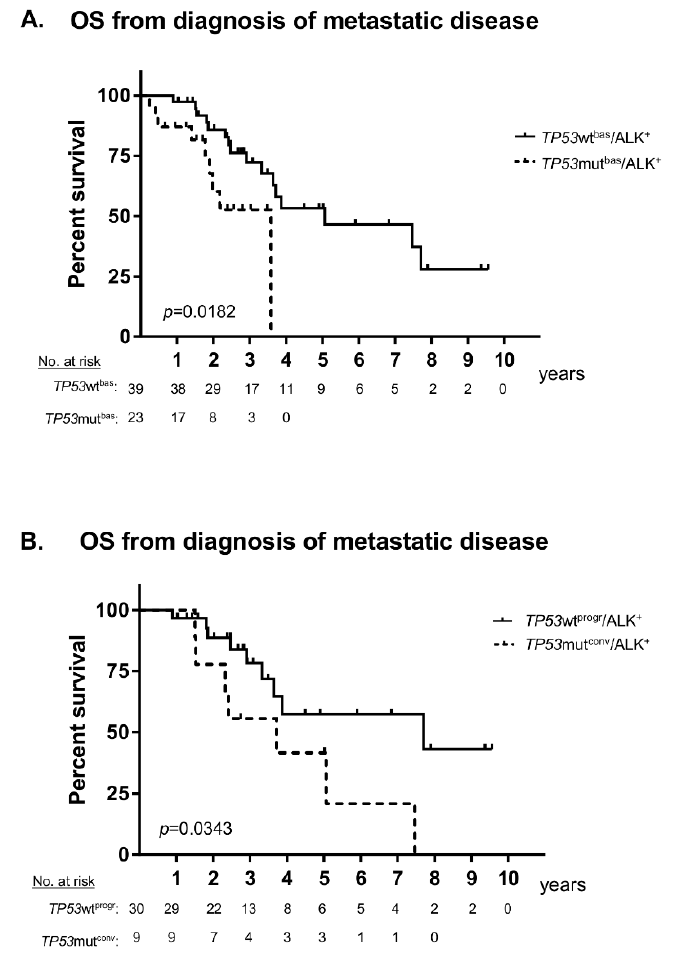
Figure 1. Overall survival of patients with metastatic anaplastic lymphoma kinase-positive (ALK + ) non-small cell lung cancer (NSCLC) according to TP53 status at baseline and progression. ( A ) The median overall survival (OS) was 44 months for patients with TP53 mutations at baseline ( TP53 mutbas) vs. 62 months for patients without TP53 mutations at baseline ( TP53 wtbas logrank p = 0.0182). ( B ) The median OS was 45 months for patients with initially wild-type status and detection of TP53 mutations in a subsequent biopsy ( TP53 mutconv) vs. 94 months for patients without subsequent detection of TP53 mutations ( TP53 wtprogr, logrank p = 0.0343). Treatment details are given in Table 1.